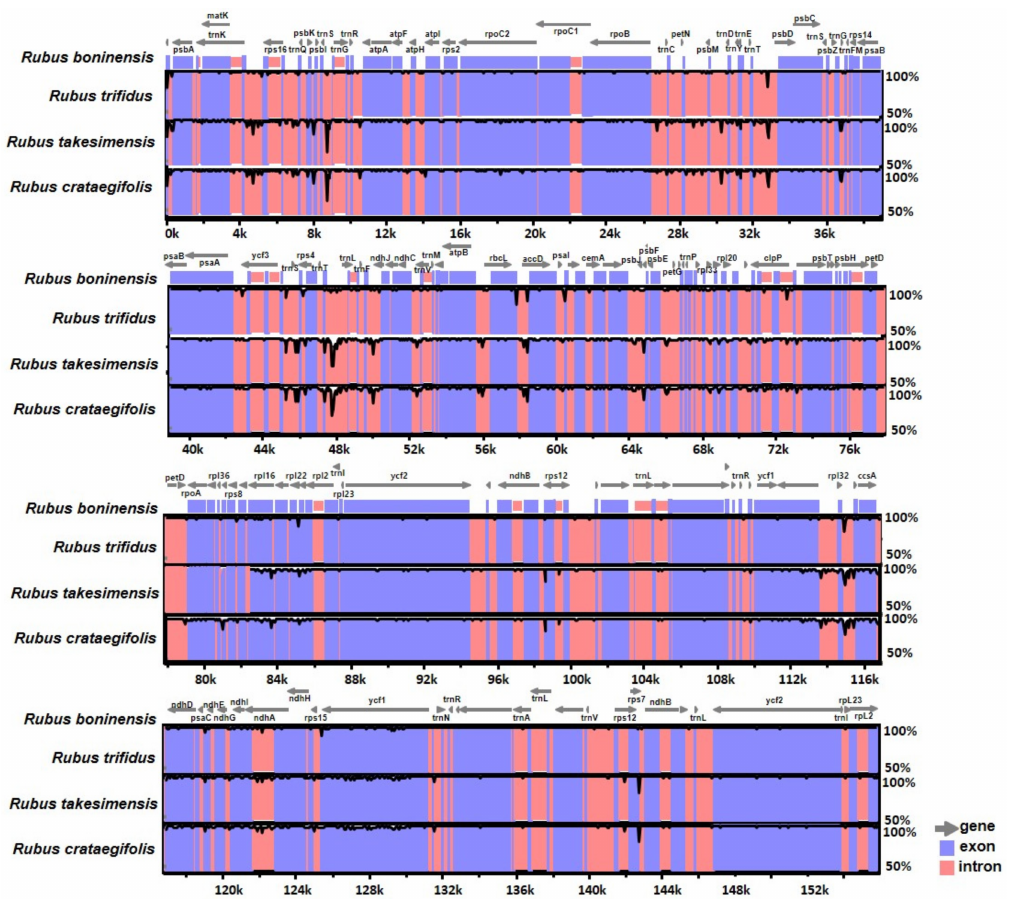
Figure 3. Visualization of alignment of four Rubus species’ chloroplast genome sequences. The VISTA-based identity plots show the sequence identity of four chloroplast genomes with reference to R. boninensis . Vertical scale indicates the percent identity from 50% to 100%. Coding and non-coding regions are in blue and pink, respectively. Gray arrows above the alignment indicate the position and direction of each